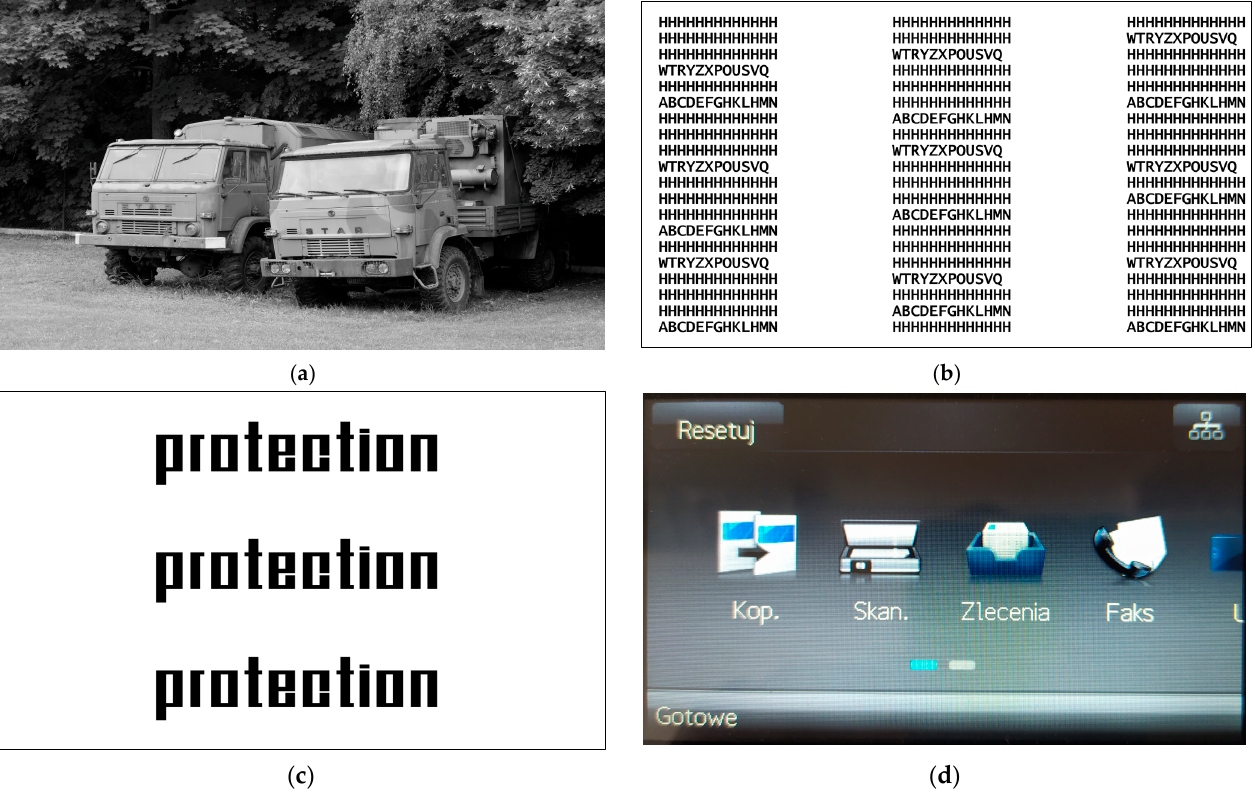
Figure 7. Test images used in the analysis of the effectiveness of the proposed measures in the process of determining the correct number of lines of the reproduced image: ( a ) a photo showing two vehicles (HDMI standard), ( b ) a three-column text (HDMI standard), ( c ) three words “protection” written in secure font (VGA standard), ( d ) menu of multifunctional device.